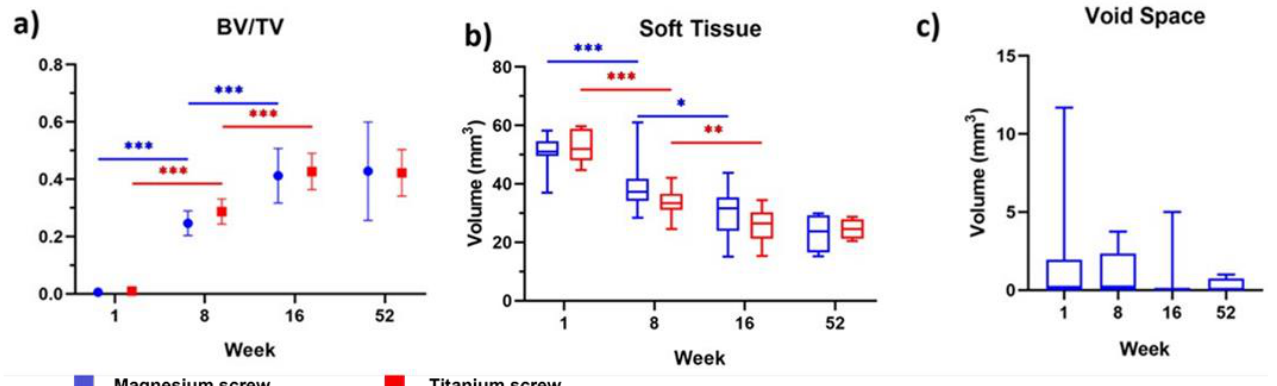
Figure 3. µCT measured values of ( a ) new bone volume/total defect volume, ( b ) soft tissue volume, and ( c ) total void (gas cavity) volume in the defect. Results shown are for defects treated with a bovine bone graft and a collagen membrane fixated with either magnesium (blue) or titanium (red) fixation screws. At each timepoint in ( a , b ), there are no significant differences between each treatment group. In ( c ), there are no significant differences between each sequential timepoint. Error bars show the standard deviation in ( a ) and the range in ( b , c ). p values are represented on the figures as follows: p < 0.05: *, p < 0.01: **, and p < 0.001: ***. Table 1. µCT volume measurements for treated GBR defects covered with a collagen barrier mem- brane that is fixated with either magnesium or titanium fixation screws.